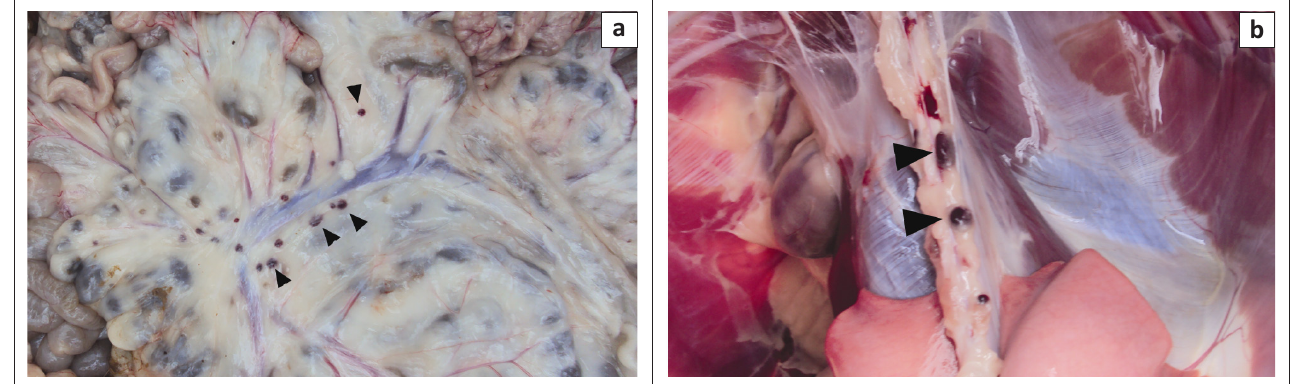
FIGURE 1: PPR-suspected animals showing (a) diarrhoea and (b) erosions on the palate and gums (see arrow heads). a